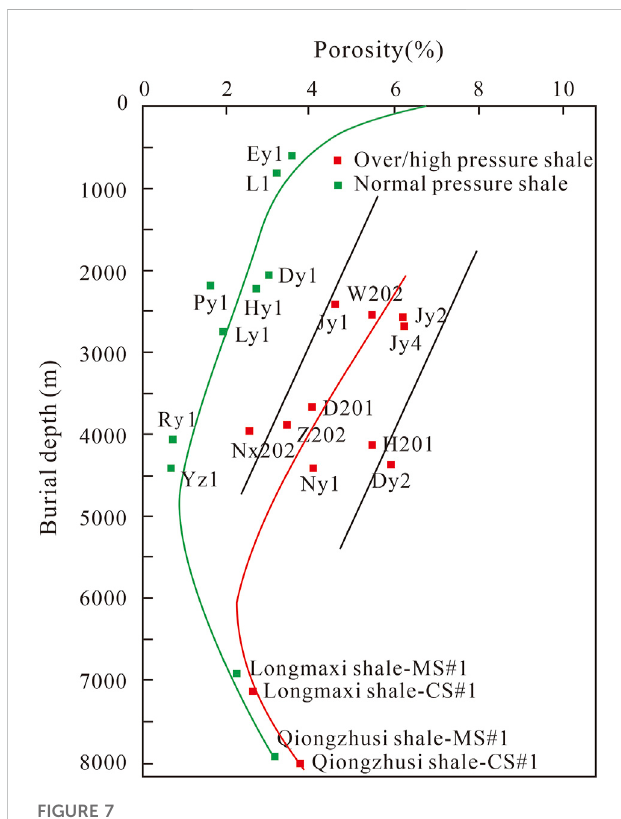
FIGURE 7 Relationship between porosity of the shale reservoir and burial